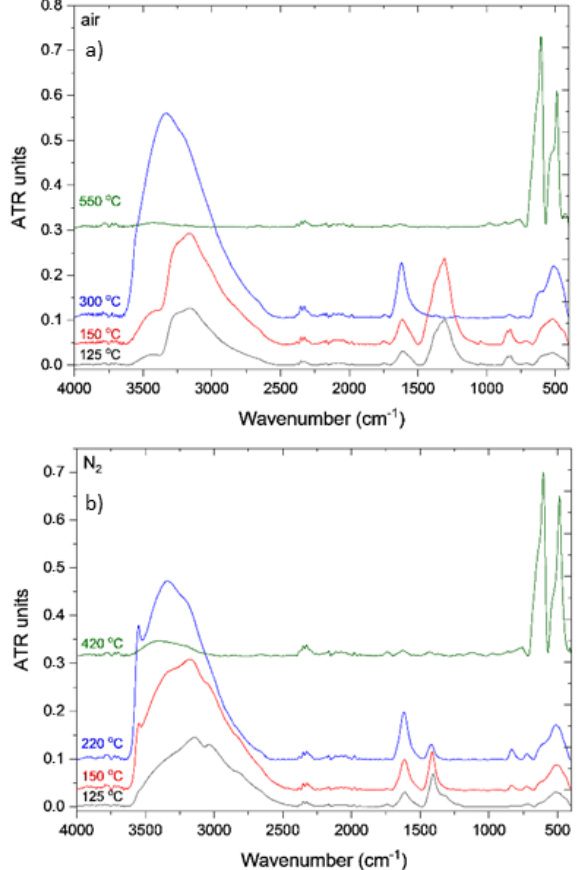
Figure 9. IR spectra of thermal decomposition intermediates of compound 3-Mn formed under air ( a ) and nitrogen ( b ) atmospheres.